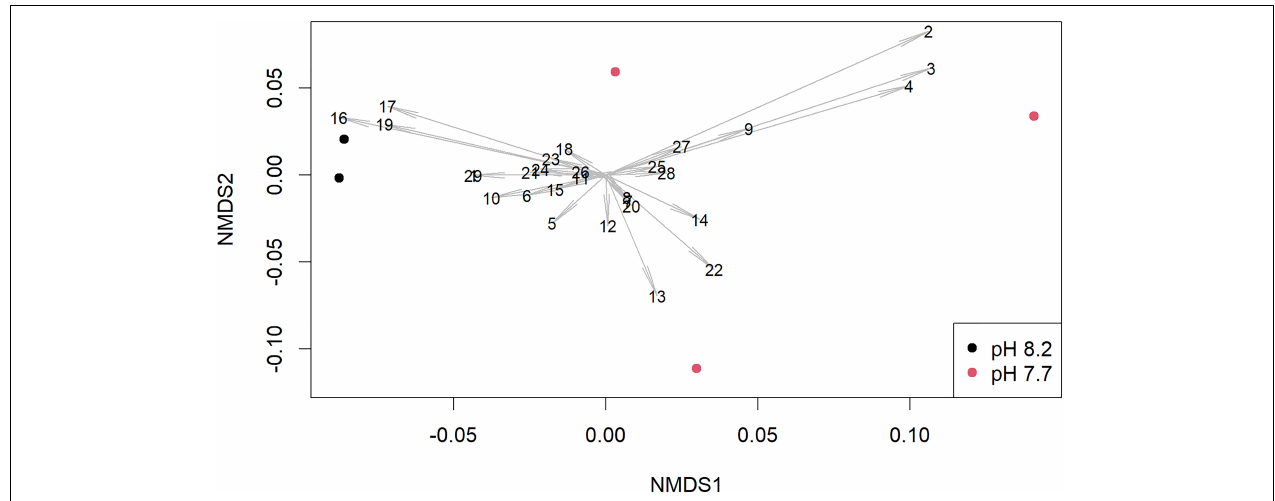
FIGURE 4 | Non-metric multidimensional scaling (NMDS) plot of the abundance of volatile organic compounds (VOCs) normalized to internal standard from Ulva prolifera depending on culture pH level. Dots indicate independently replicate and separately analyzed cultures of the same algal isolate, distances between dots indicate Bray-Curtis dissimilarities, arrow lengths indicate the contribution of the respective peak to the dissimilarity, numbers indicate the peak-identities (see Supplementary Table 6